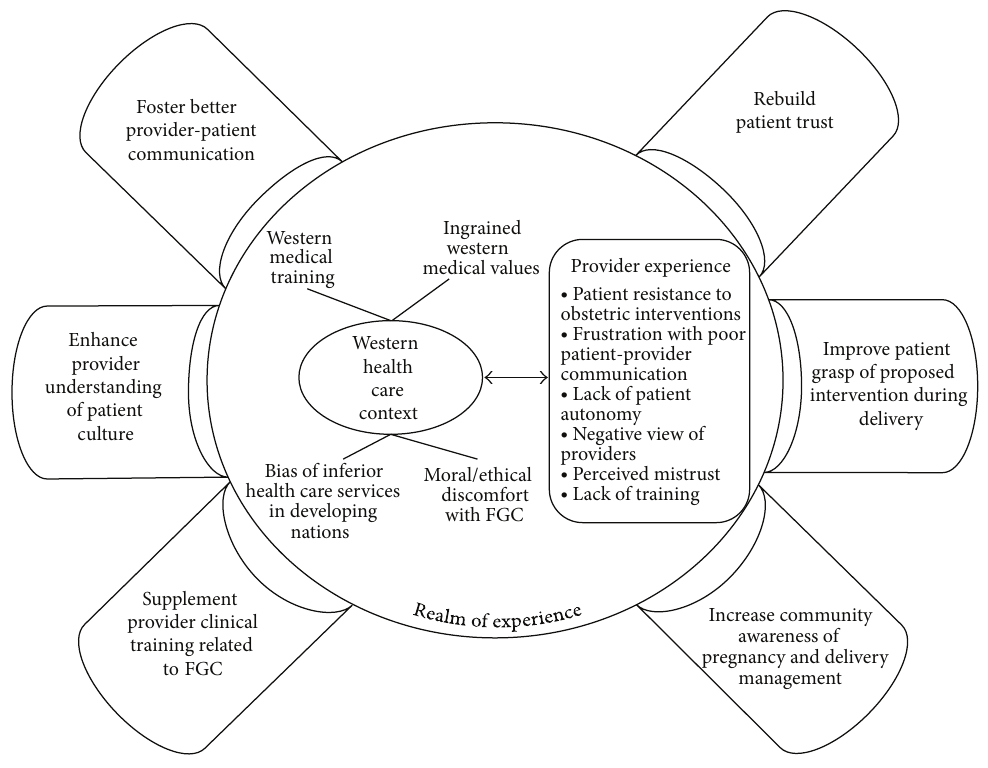
Figure 1: Mechanisms to improve the quality of care. Adapted from